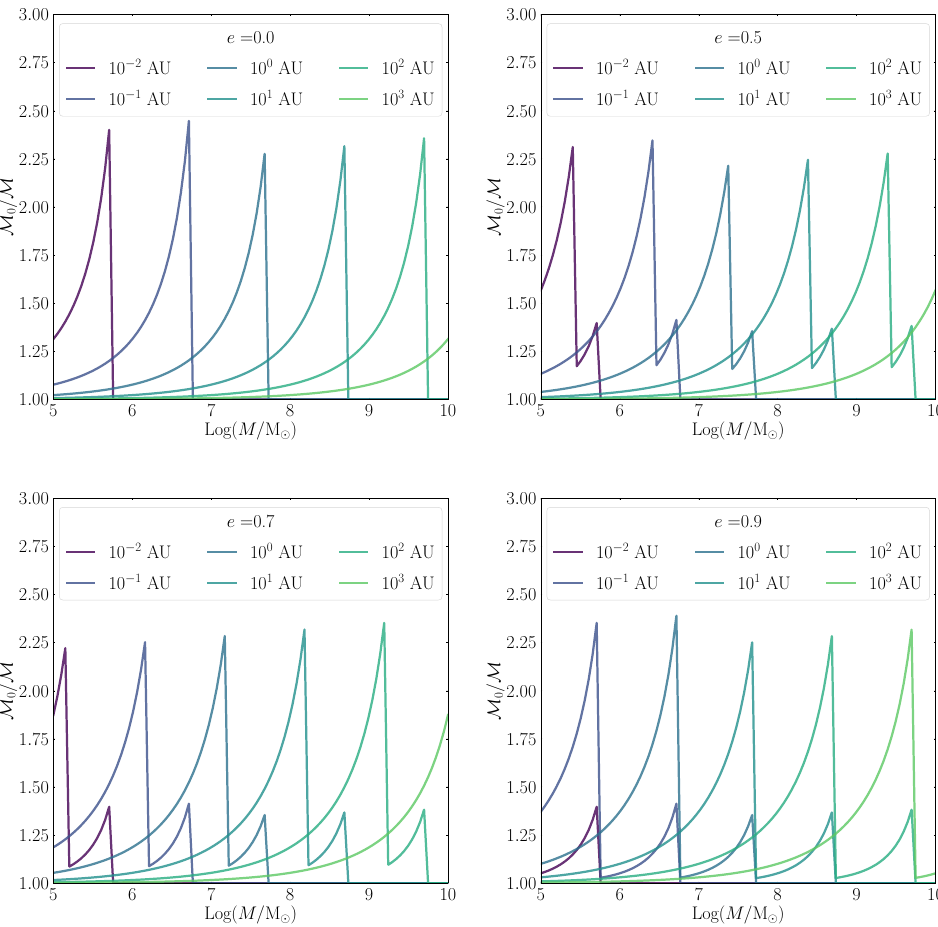
Figure 16. Total chirp mass correction factor as a function of the SMBH mass and for different values of the BBH–SMBH separation, assuming that theBBHs undergo a merger at redshift z = 0 and move around the SMBH on an orbit with an eccentricity e = 0–0.5–0.7–0.9. It is worth noting that a BBH with mass m bin = 50 M at a distance r = 1 mpc (cid:12) from an SMBH with mass M SMBH = 10 6 ( 10 8 ) M revolves around the SMBH in a time (cid:12) of P 2 3 ( 0.3 ) yr; thus, a detector with a mission lifetime ( τ life ) longer than the (cid:39)